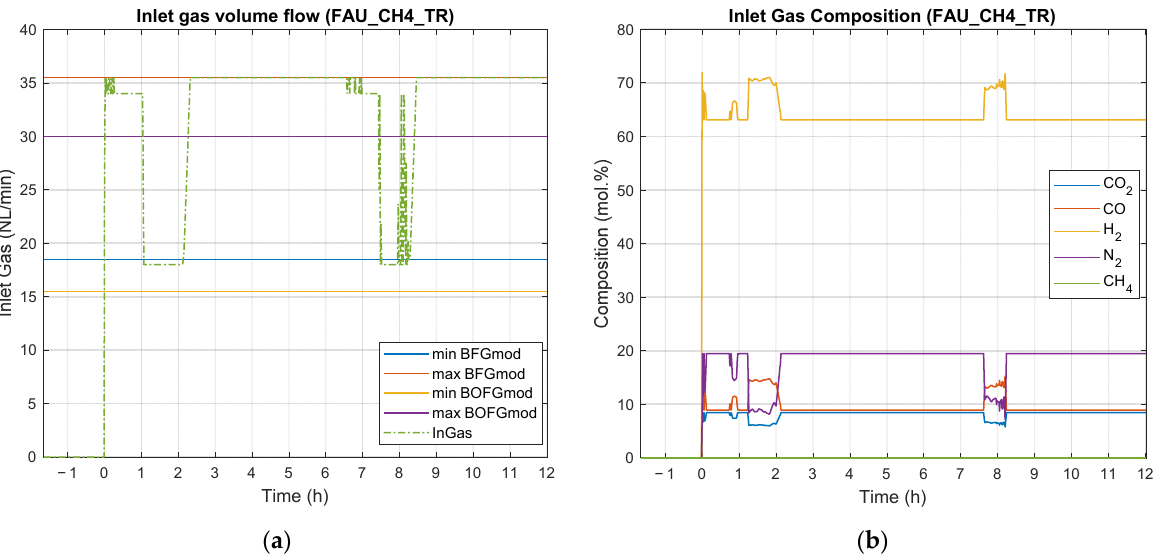
Figure 9. SC1. Control strategy for FAU_CH4_TR. ( a ) Inlet gas volume flow; ( b ) inlet gas composi- tion.